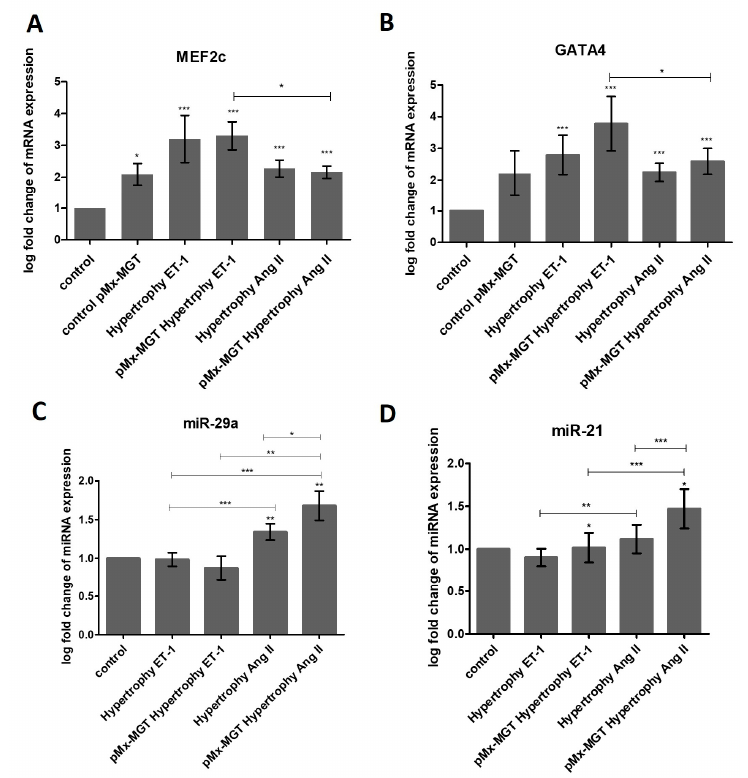
Figure 7. Gene expressions of MEF2c ( A ) and GATA4 ( B ) were significantly upregulated in all treatment groups ( p < 0.005) with differences between Ang II and ET-1 ( p < 0.05). MEF2c and GATA4 both were higher in the ET-1 groups. ( C ) miR-29a was significantly upregulated in both Ang II treated groups ( p < 0.05), and ( D ) miR-21 was upregulated when cells were previously transfected with pMx-MGT in the Ang II treatment group. pMx-MGT hypertrophy ET-1-treated cells were downregulated in miR-21 expression compared to control group ( p < 0.02).